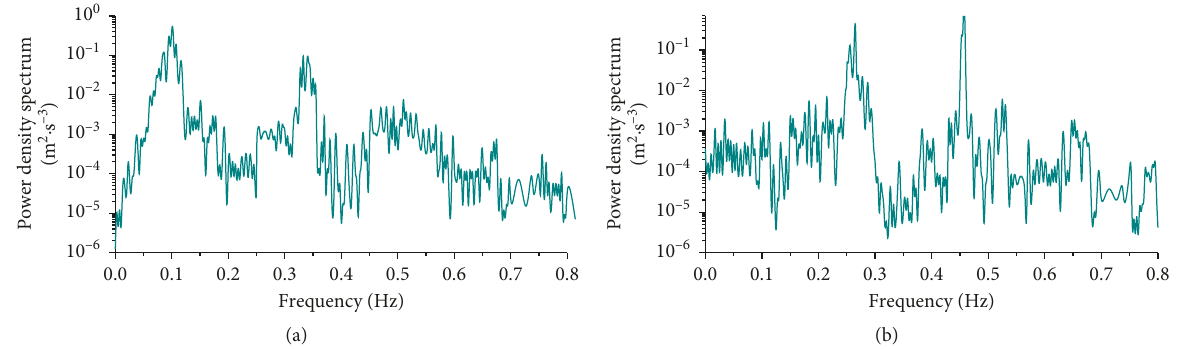
Figure 6: Power density spectrum in the middle of the bridge girder at 5.0m/s: (a) vertical and (b) transverse.